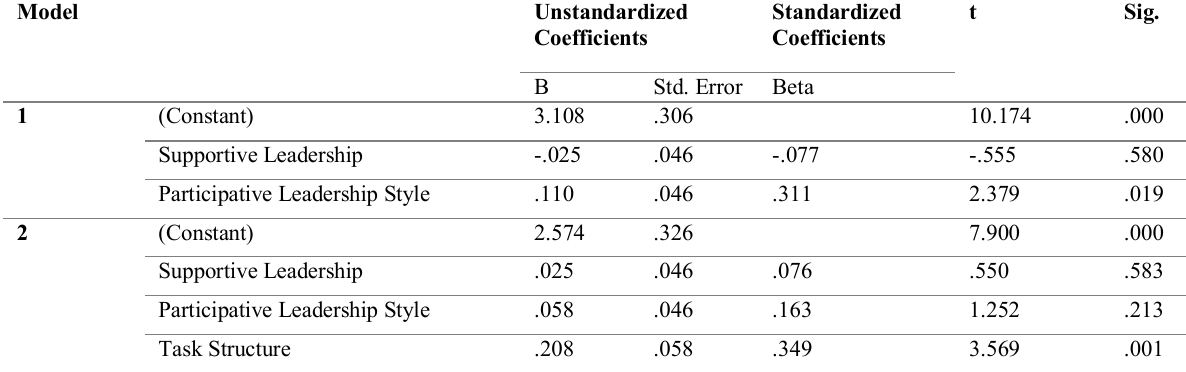
Table 15: Regression coefficients after